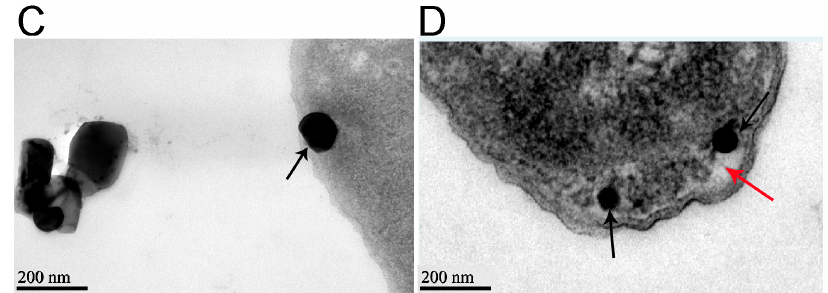
Figure 4. Transmission electron microscopy of the process of adsorption of iron oxide nanoparticles to E. coli . The bacteria, at 10 7 colony forming units (CFU)/mL, were exposed to 0.5 mM iron oxide nanoparticles at 37 °C for 4 h in PBS. ( A ) Iron oxide nanoparticles approach the cell membrane and begin to invade, as indicated by the black arrow; ( B ) Iron oxide nanoparticles embed in the cell membrane and complete semi-penetrating, as indicated by black arrows; ( C ) Iron oxide nanoparticles are completely through the cell membrane, as indicated by the black arrow; ( D ) Iron oxide nanoparticles enter the cytoplasm, as indicated by black arrows; and vacuoles, indicated by red arrows, form around the nanoparticles in the cytoplasm.